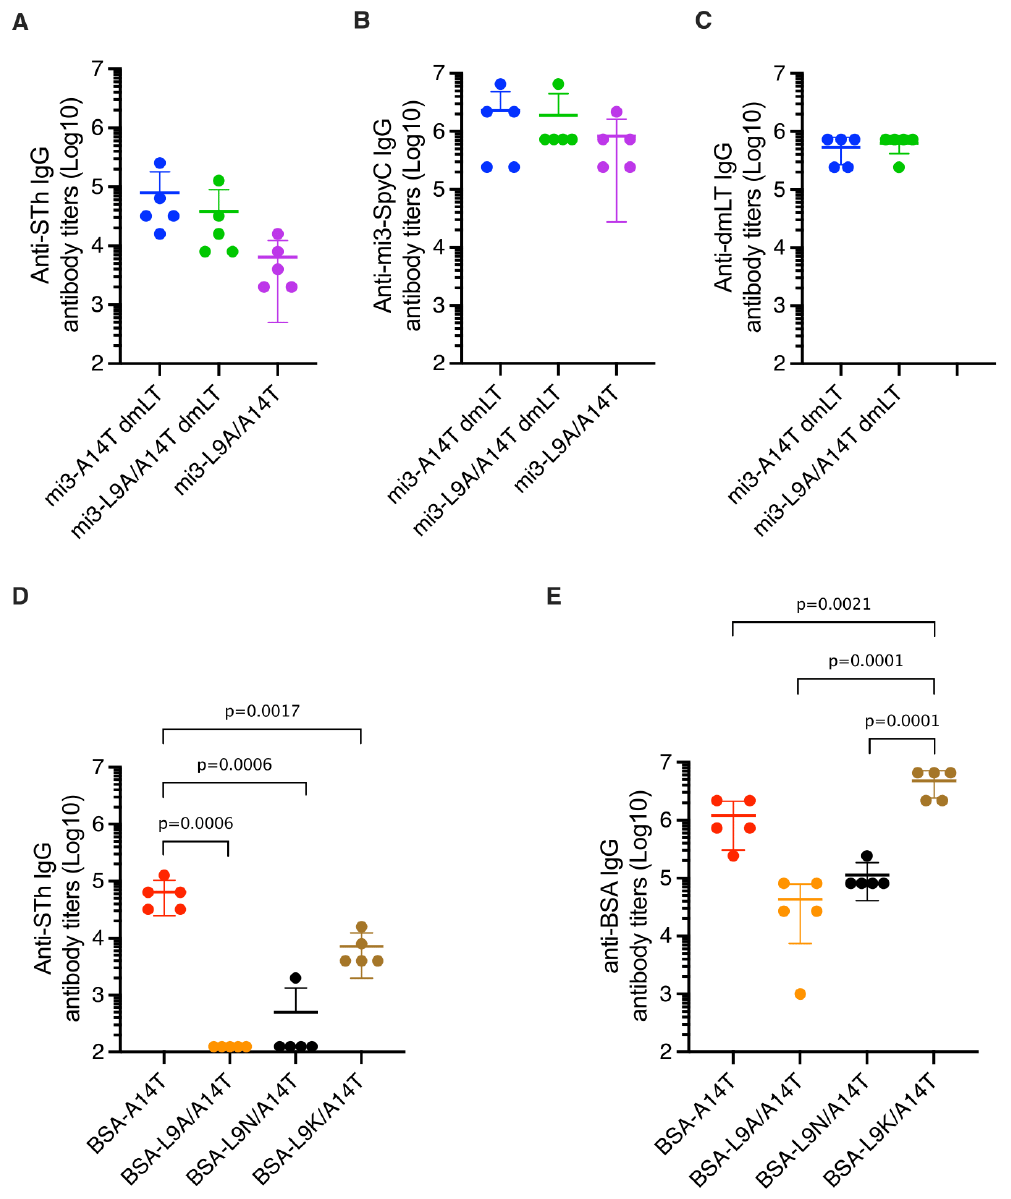
Figure 3. Endpoint IgG antibody titers. The plots show anti-STh IgG ( A ), anti-mi3-SpyC IgG ( B ), and anti-dmLT IgG ( C ) antibody titers of sera from mice immunized with mi3 nanoparticles, and anti-STh IgG ( D ) and anti-BSA IgG ( E ) antibody titers of sera from mice immunized with BSA conjugates. Sera were named according to carrier (BSA or mi3) and STh mutant residues, and dmLT was appended to the name to indicate when dmLT was used as adjuvant. The titers were defined as the highest dilutions that had signal over background ratios of ≥ 2.1, and the horizontal lines represent the titer mean for each sera group ( n = 5). Sera means that were statistically significantly different are indicated above the plots by their p -values, as estimated using ordinary one-way ANOVA and Tukey’s multiple comparison test. Error bars represent standard deviations (SD) of the means; negative values are not depicted. Additional details of the sera analyses are presented in Table S1.